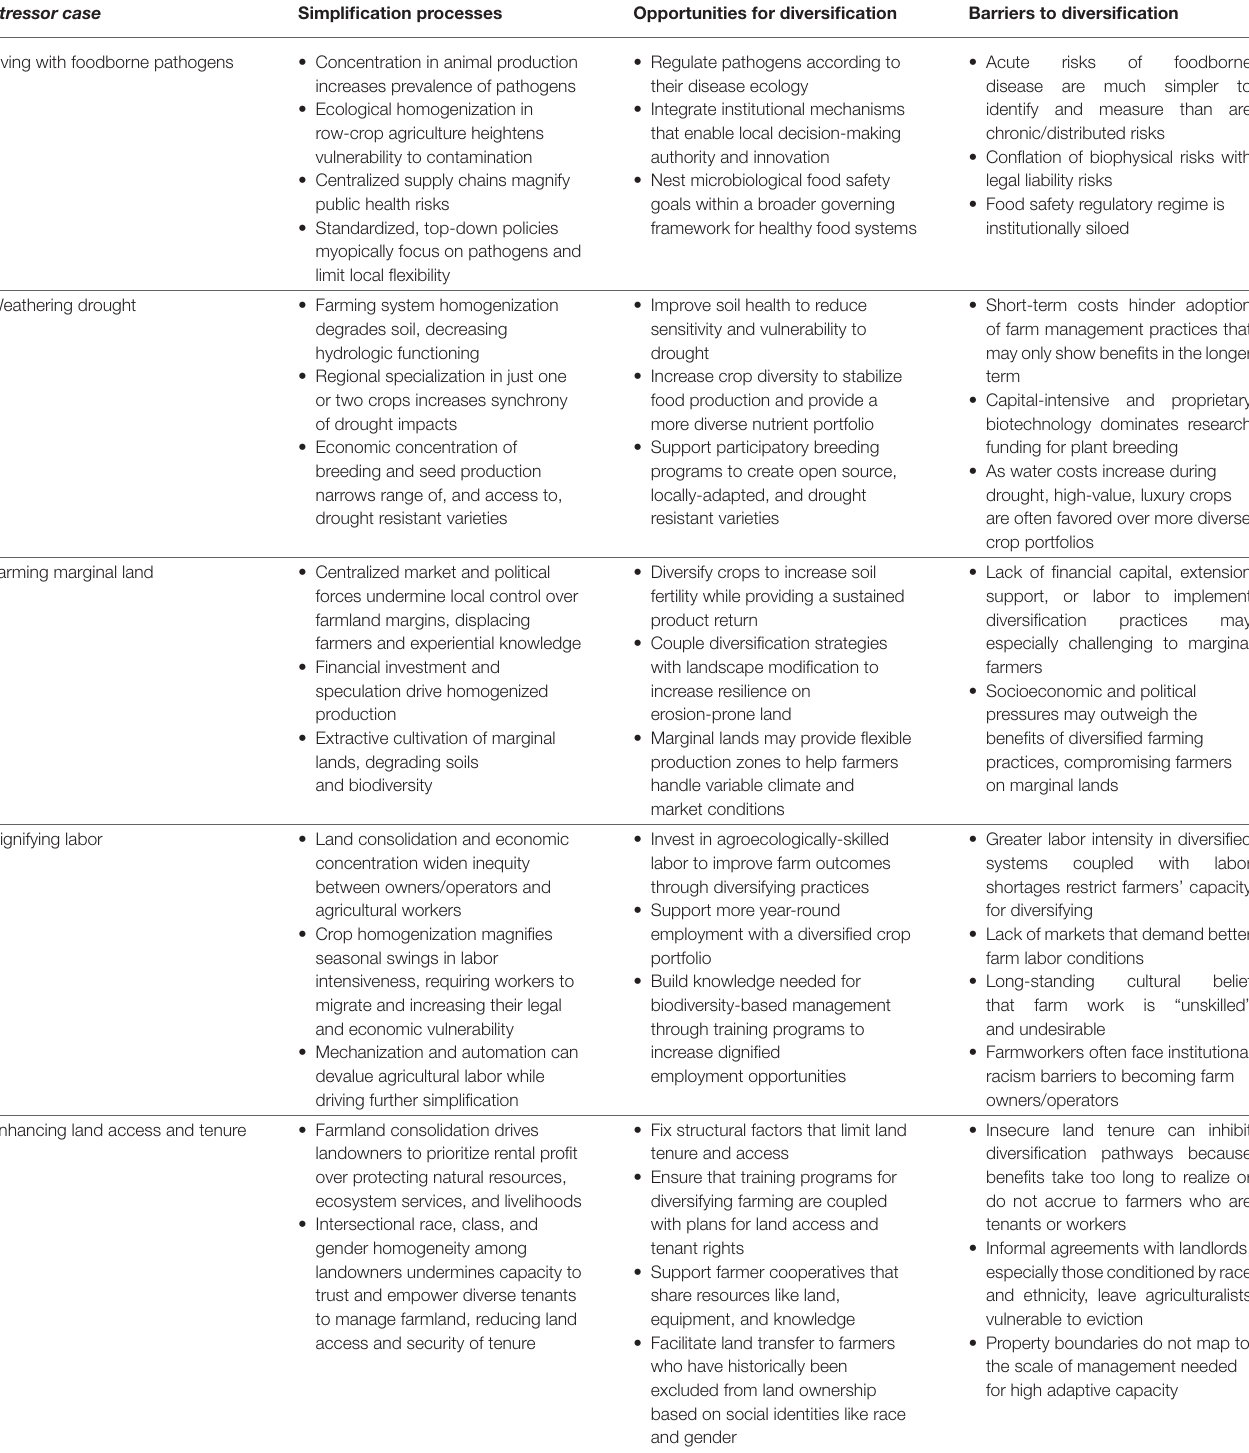
TABLE 2 | Simplification processes, opportunities for and barriers to diversifying processes through which farming systems could strengthen agricultural adaptive